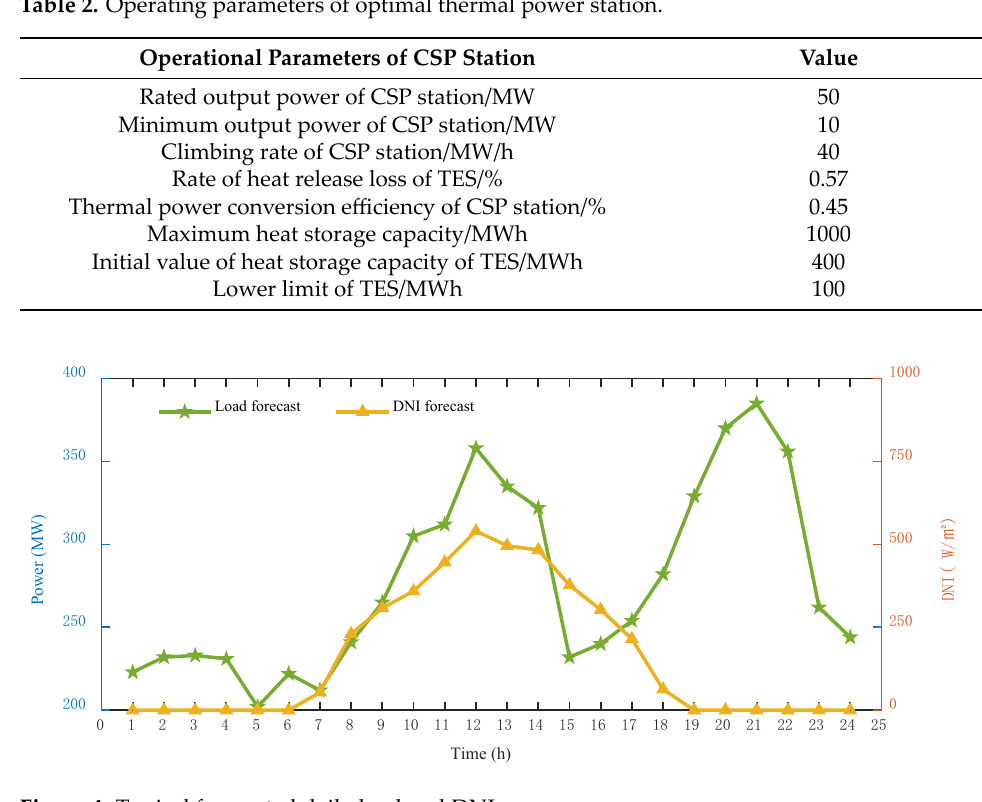
Figure 4. Typical forecasted daily load and DNI.